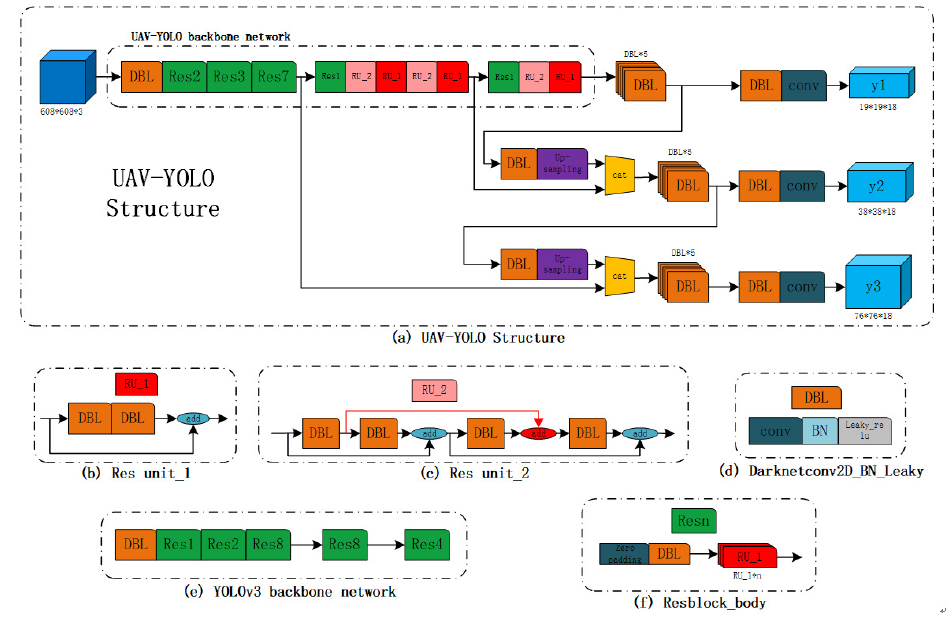
Figure 1. The structure of our proposed